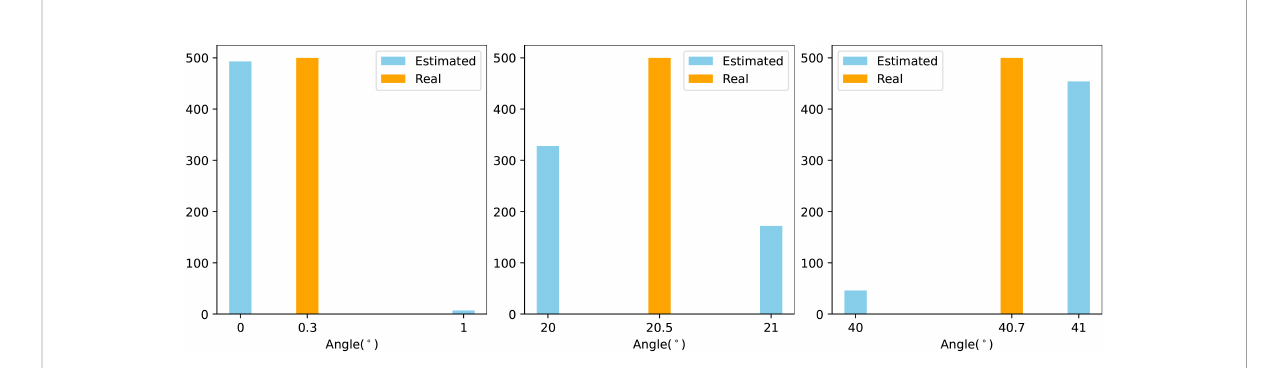
FIGURE 5 DOA estimation results in three different non-integer angles (0.3°, 20.5°, and